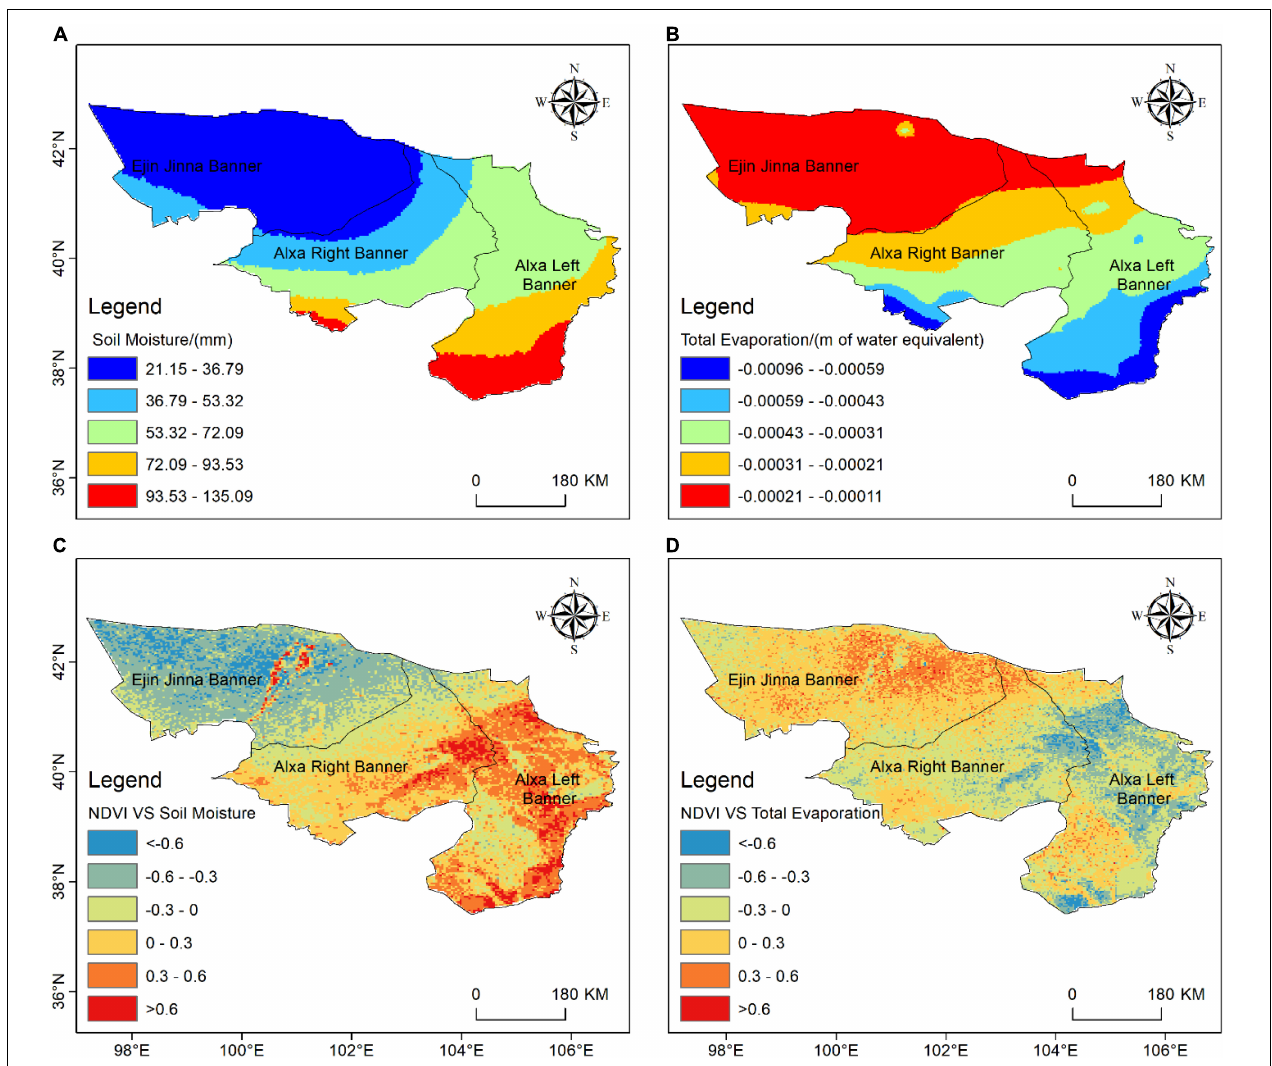
FIGURE 8 | Spatial distribution of mean soil moisture and total evaporation in Alxa League from 2000 to 2019 and their correlation with